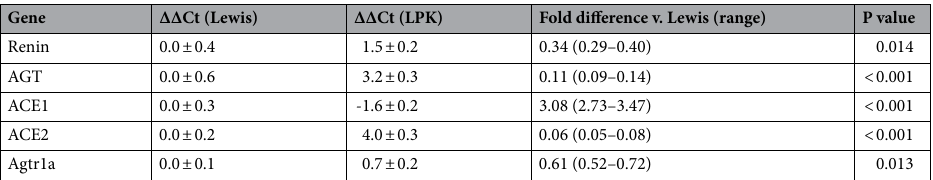
ΔΔCt Fold difference v. sham (range) Gene